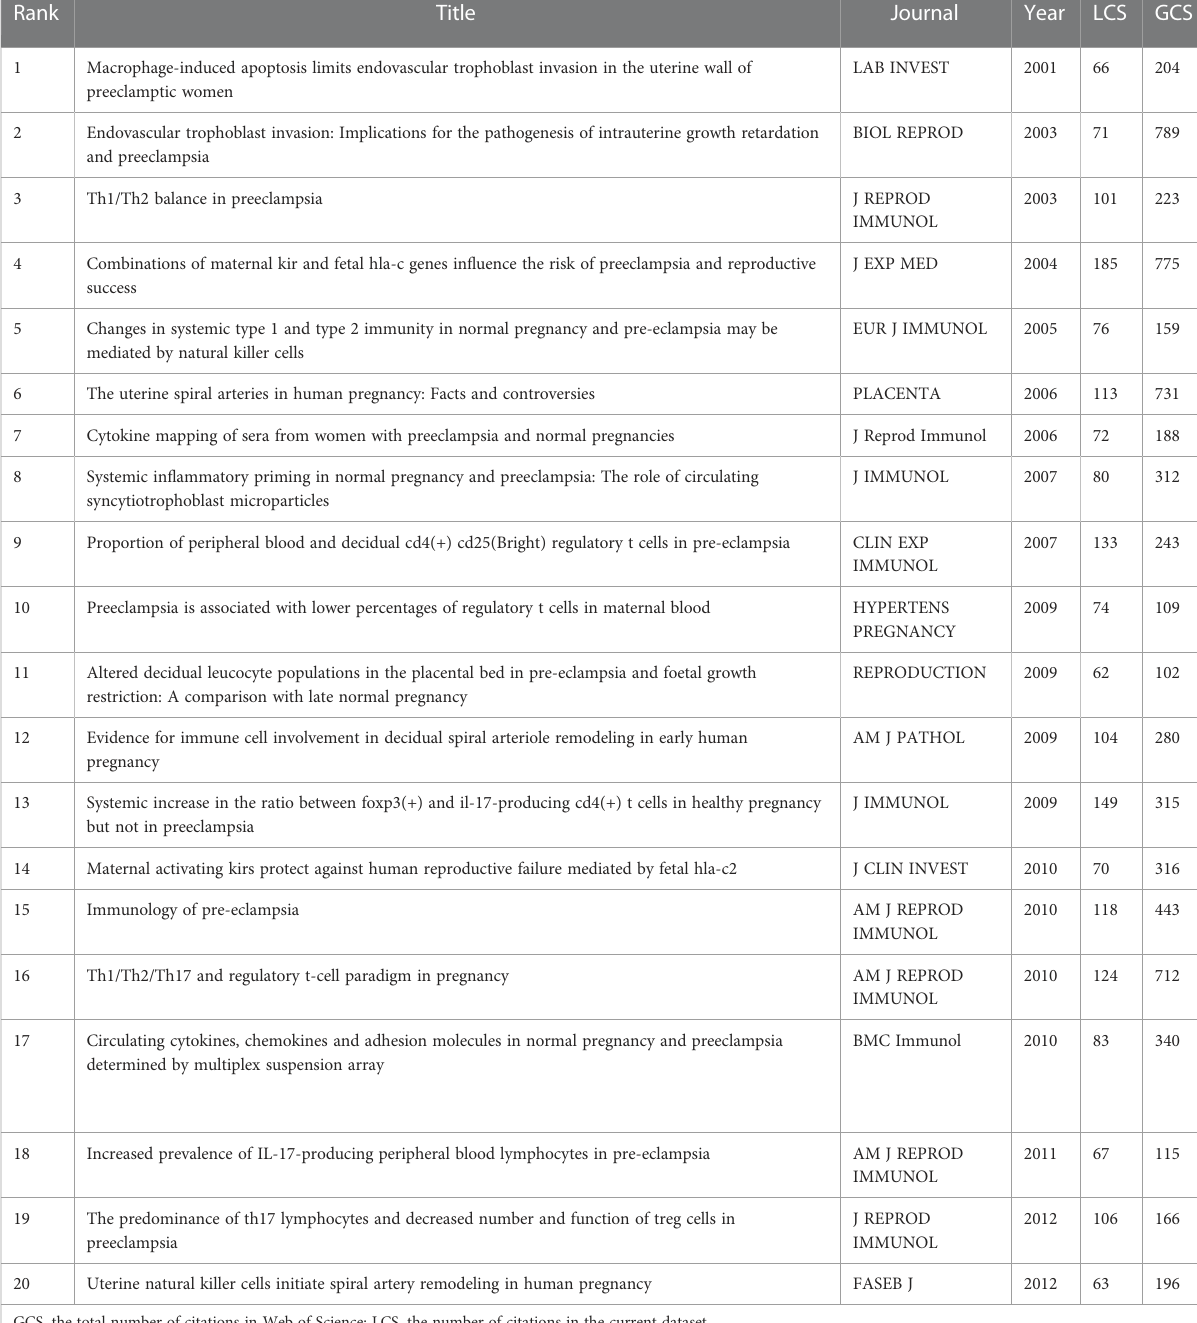
TABLE 4 Historiograph of HDP and immune cells research.